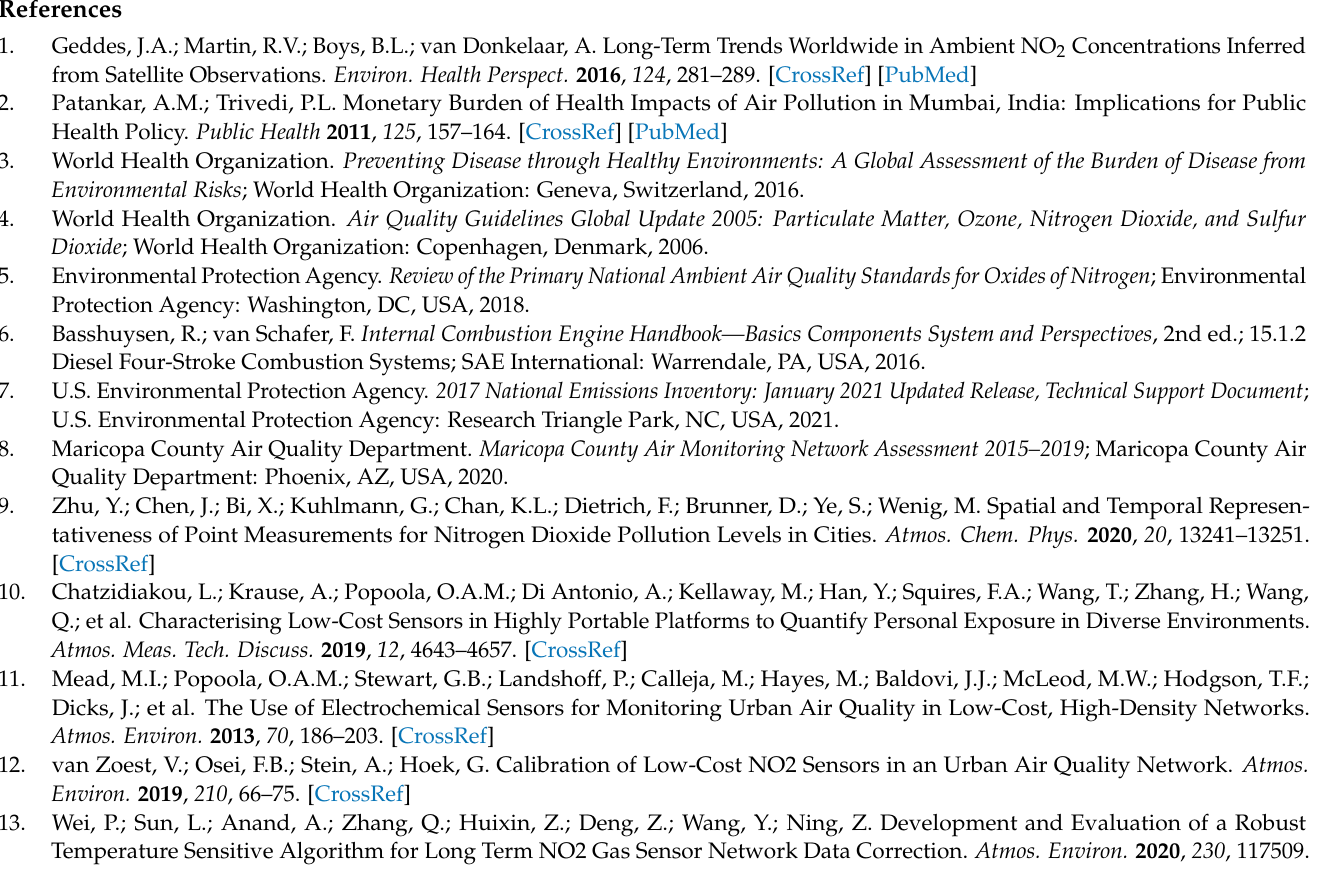
Figure S2: RMSE, MAE, R 2 , and slope comparisons for raw and Clarity 15-day calibrated data with training data excluded, Figure S3: Environmental factor comparison for the 15-day calibration period and the final 15 days of LCS deployment. Table S1: Slope and Pearson correlation coefficients of West Phoenix FRM NO 2 and raw LCS data, Table S2: Slope and Pearson correlation coefficients of West Phoenix FRM NO 2 and Clarity 30-day calibrated LCs data, Table S3: Slope and Pearson correlation coefficients of West Phoenix FRM NO 2 and Ozone corrected 30-day calibrated LCs